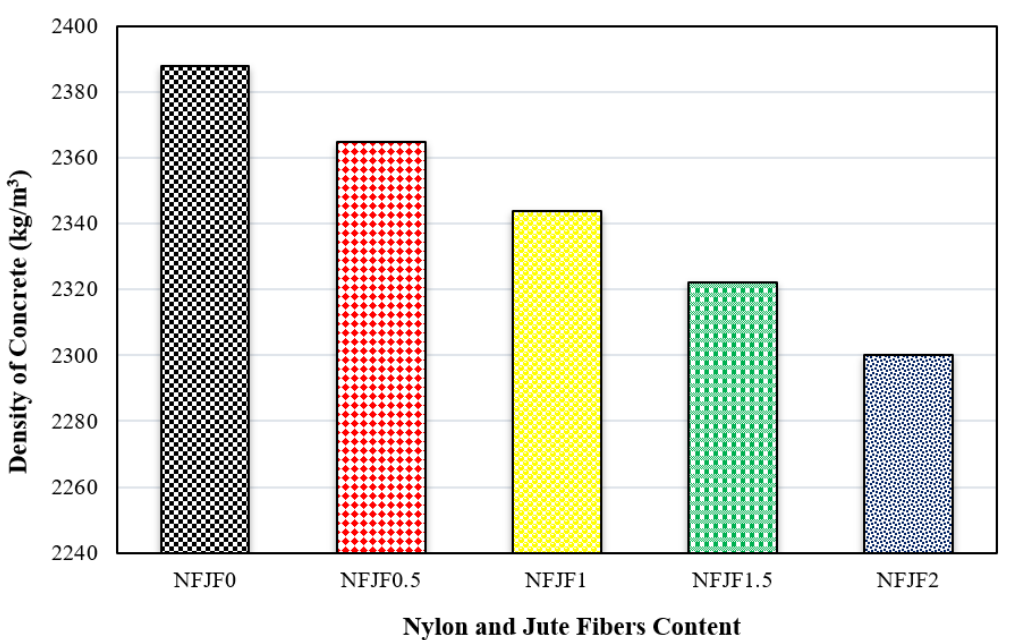
Figure 5. Density of concrete.